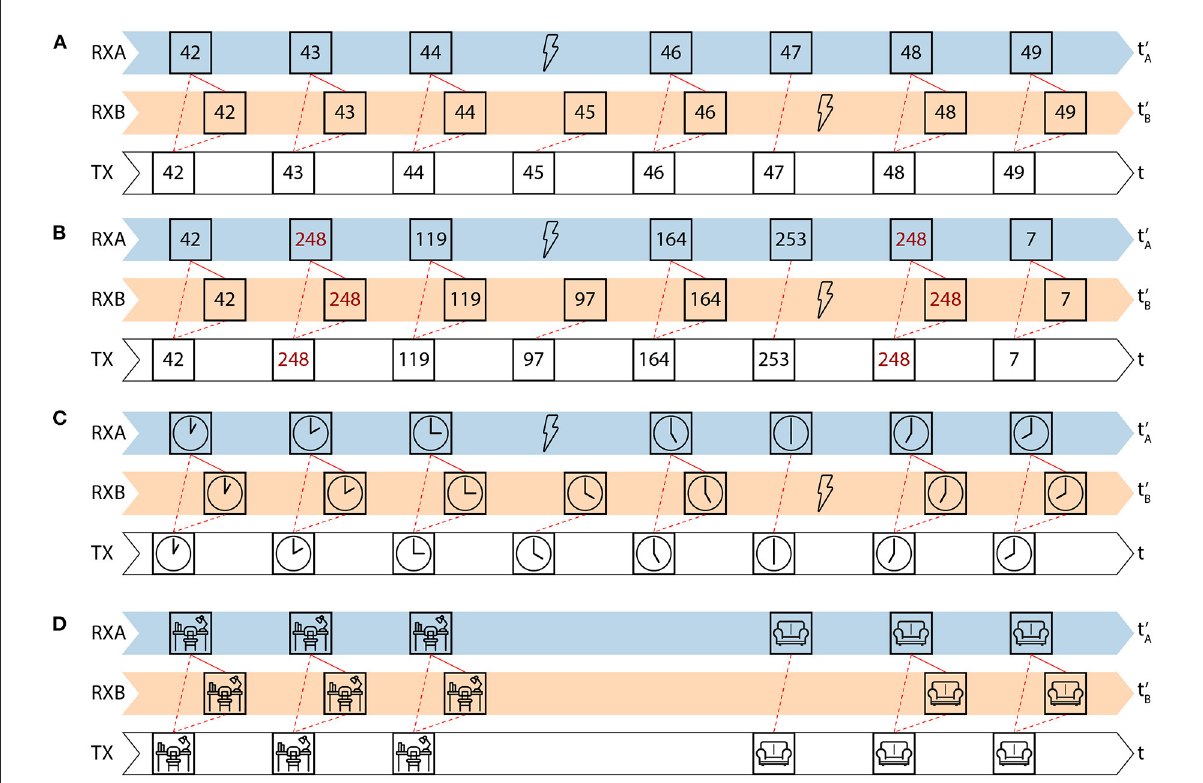
FIGURE6 Proposed applications using the data segment of the landmark packet for synchronization (A – C) and contextualization (D) : incrementing packet counter as identifier for a limited recurrence interval of 2 8 × 2.5s = 640s , 10min 40s, respectively (A) ; sequences of random numbers as unique identifier patterns for a quasi-infinite recurrence interval of ideally 2 8 ! landmarks, lasting for 6 . 8 × 10 499 years (B) ; information related to absolute time, preferentially with larger data segments of four bytes, unsigned long for ms-accurate timestamps (C) ; unique location or object identifier to provide the situational context (D)